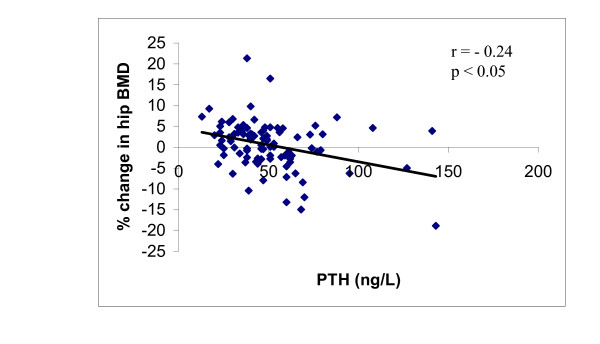
The relationship between percentage change in BMD at the total hip and PTH concentrations.